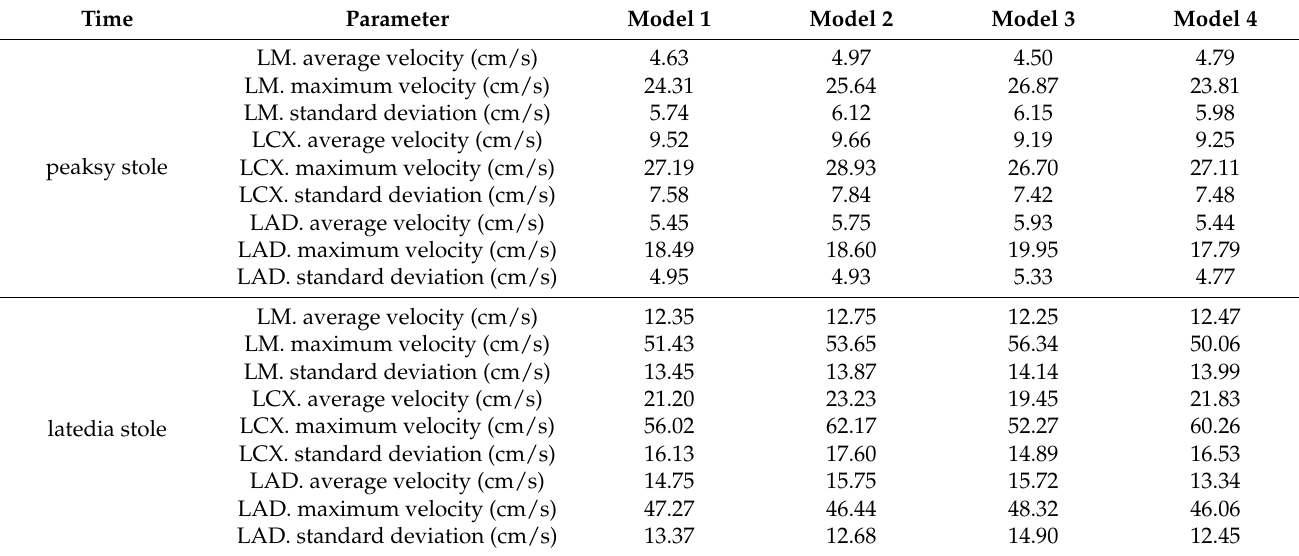
Table 2. Velocity values of each section during the peak systole and late